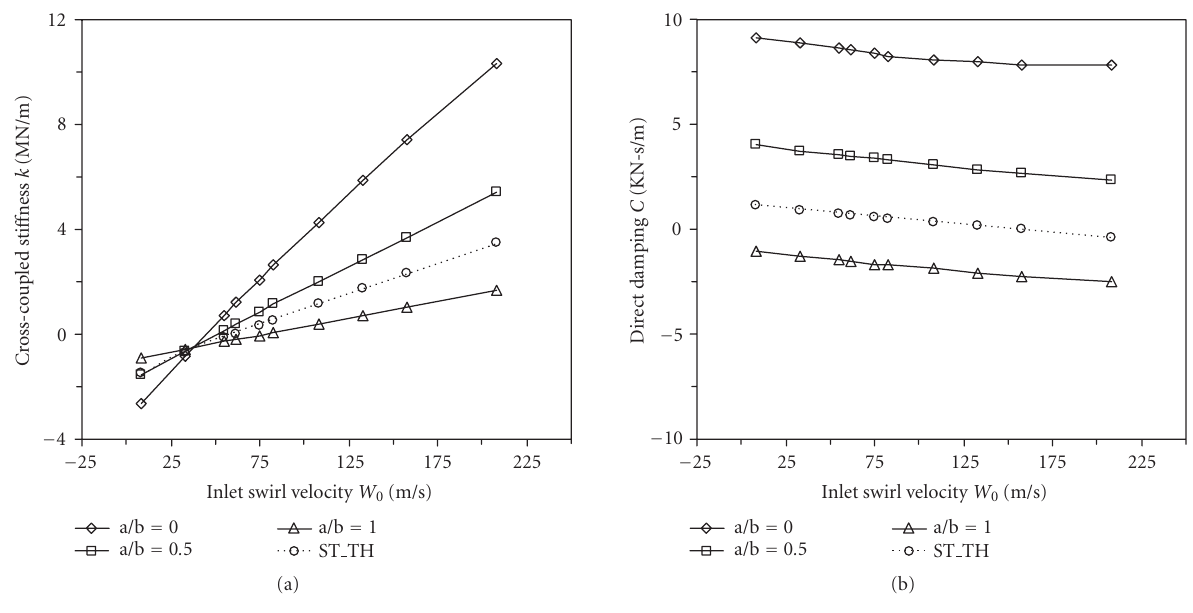
Figure 8: Plot of cross-coupled sti ff ness k and direct damping C versus inlet swirl velocity W 0 for di ff erent seal configurations: (a) cross- coupled sti ff ness; (b) direct damping.